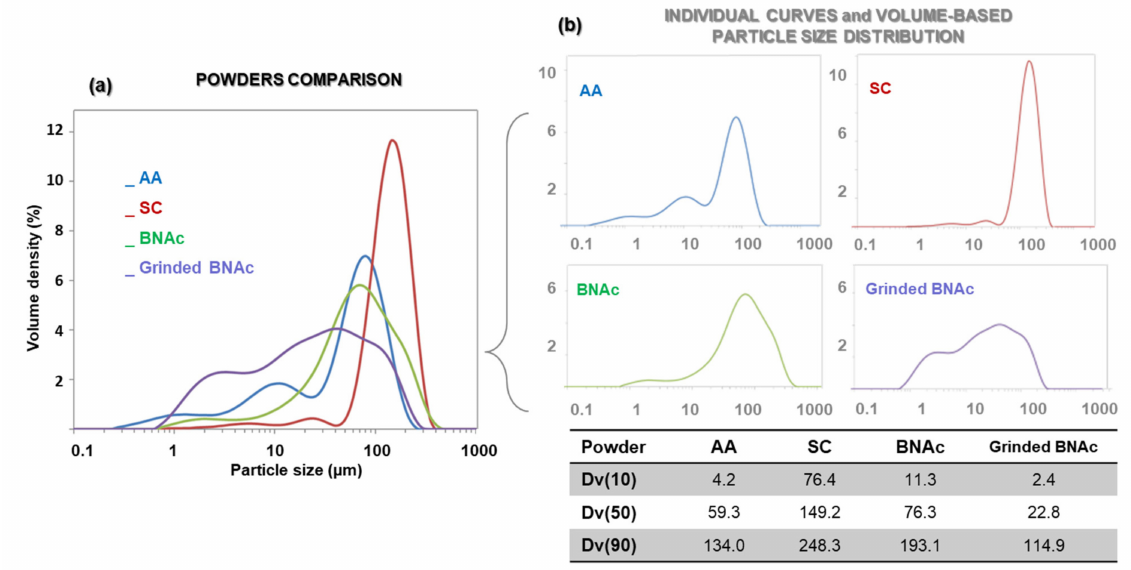
Figure 2. Particle size distribution of AA, SC, BNAc, and ground BNAc powders: ( a ) general comparison, and ( b ) individual curves and volume-based distribution coefficients.